Question: Sum up the contents of this chart in one sentence.
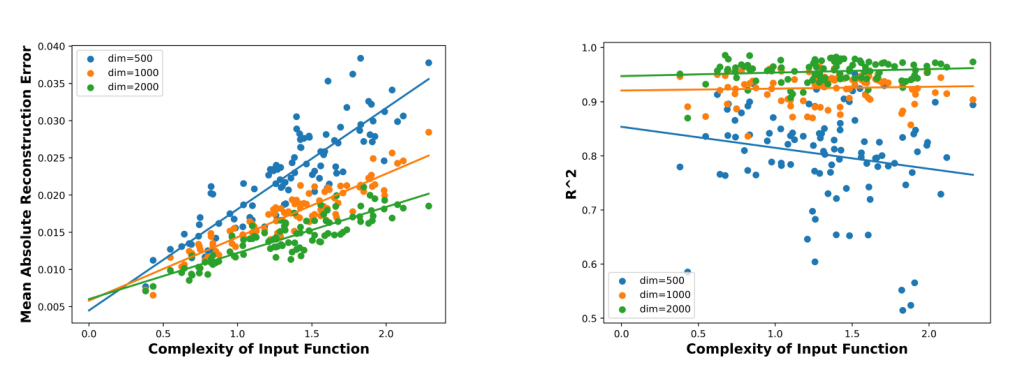
Answer: Empirical information loss when encoding functions of different complexities.